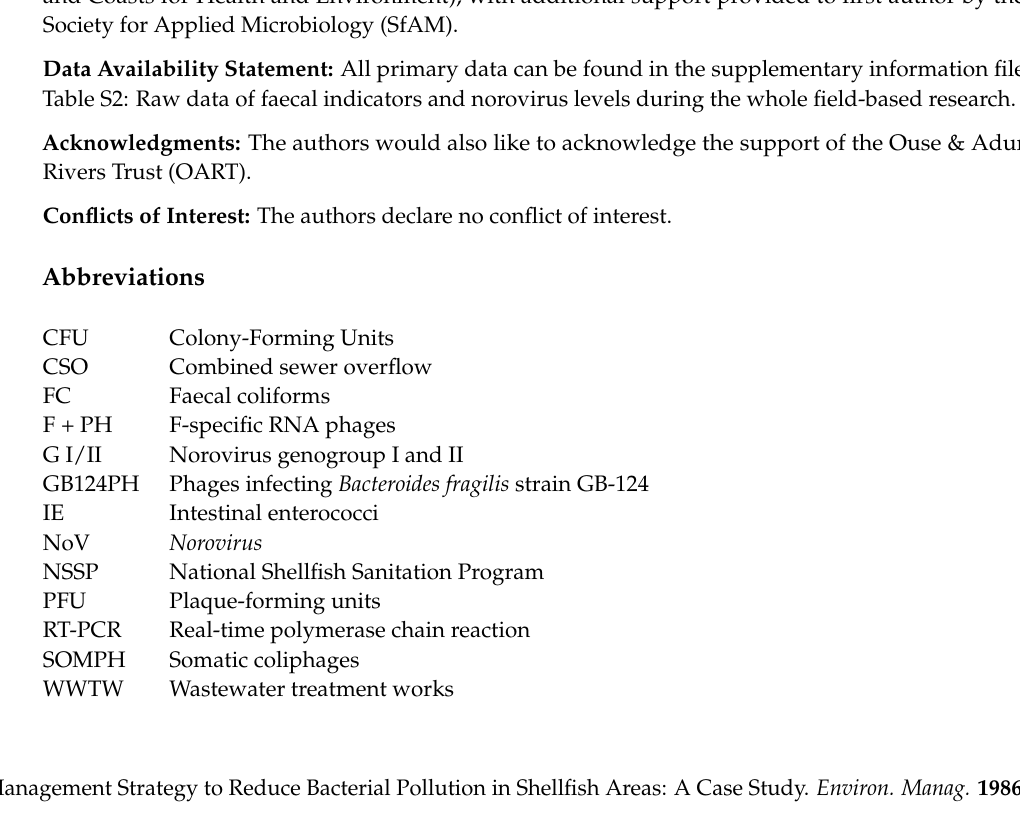
Table S2: Raw data of faecal indicators and norovirus levels during the whole field-based